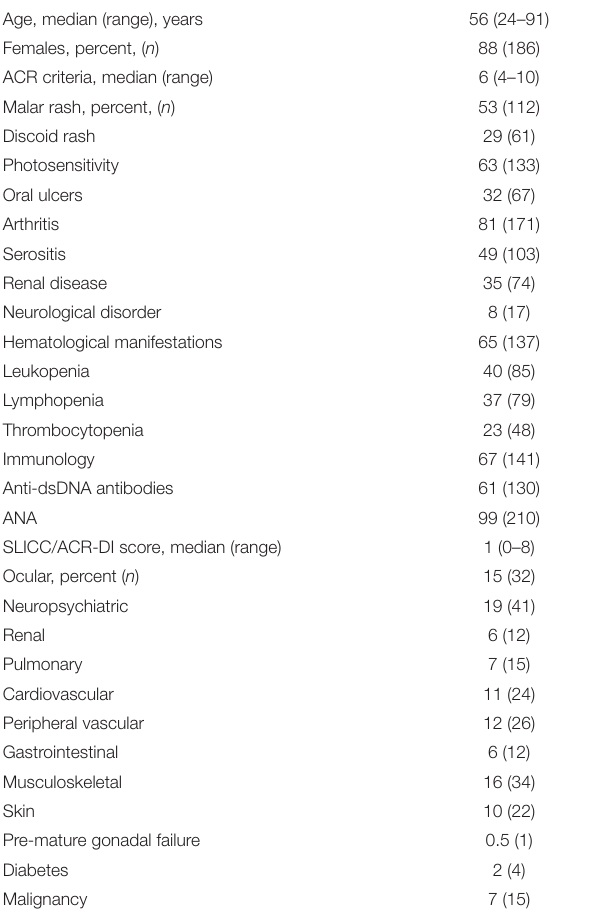
TABLE 1 | Clinical characteristics of the SLE patients ( n =